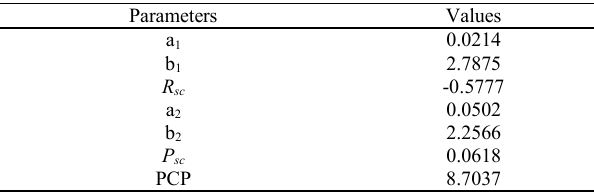
Table 1. Estimated parameters for the polyphasic growth pattern in male Anableps anableps from the mouth of the Maracanã River, Pará State (a : coefficient of proportionality 1 in phase 1; a : coefficient of proportionality in phase 2; R : 2 sc rate of change of the coefficient of proportionality between phases; P- : rate of change of the coefficient of allometry; b : sc 1 coefficient of allometry in phase 1; b : coefficient of allometry 2 in phase 2, and PCP: point of change in